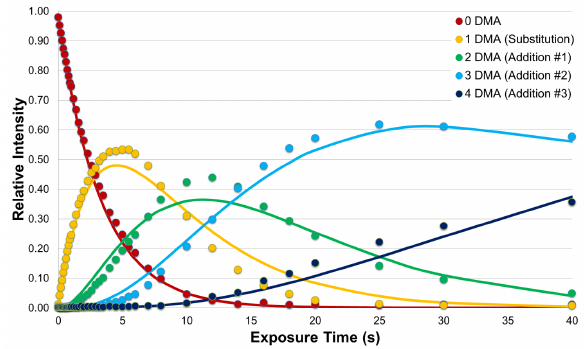
Fig. 3. Reaction profile (symbols) and statistical fit to pseudo-first order kinetics (lines) for exposure of [(NH 4 ) (HSO 4 ) 2 (H 2 SO 4 ) 3 ] − to dimethylamine gas (P dimethylamine : 2.4 ± 0.5 × 10 − 8